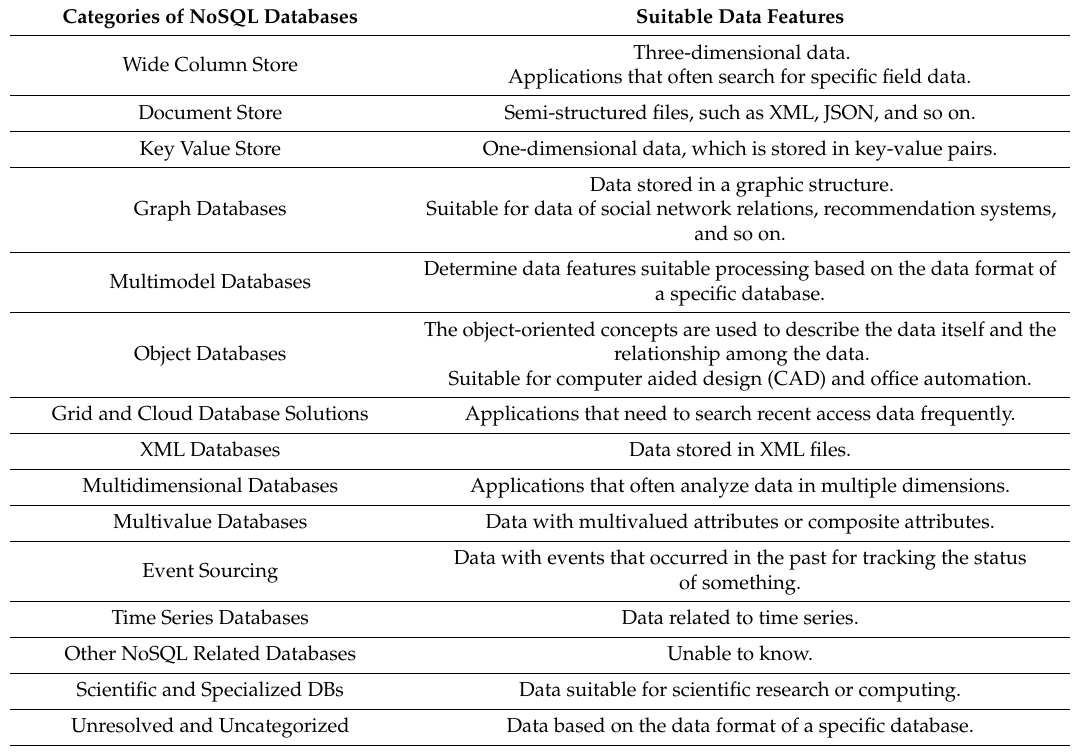
Table 7. Summary of suitable data features for NoSQL